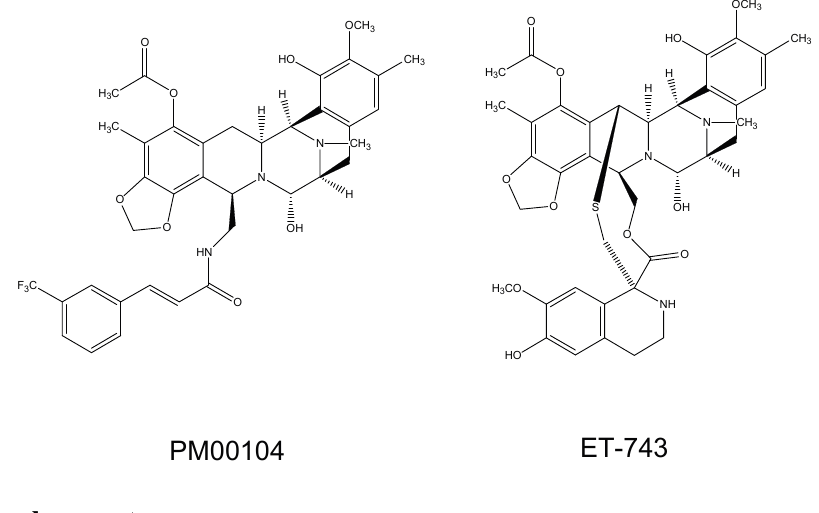
Figure 1. Chemical structures of PM00104 and